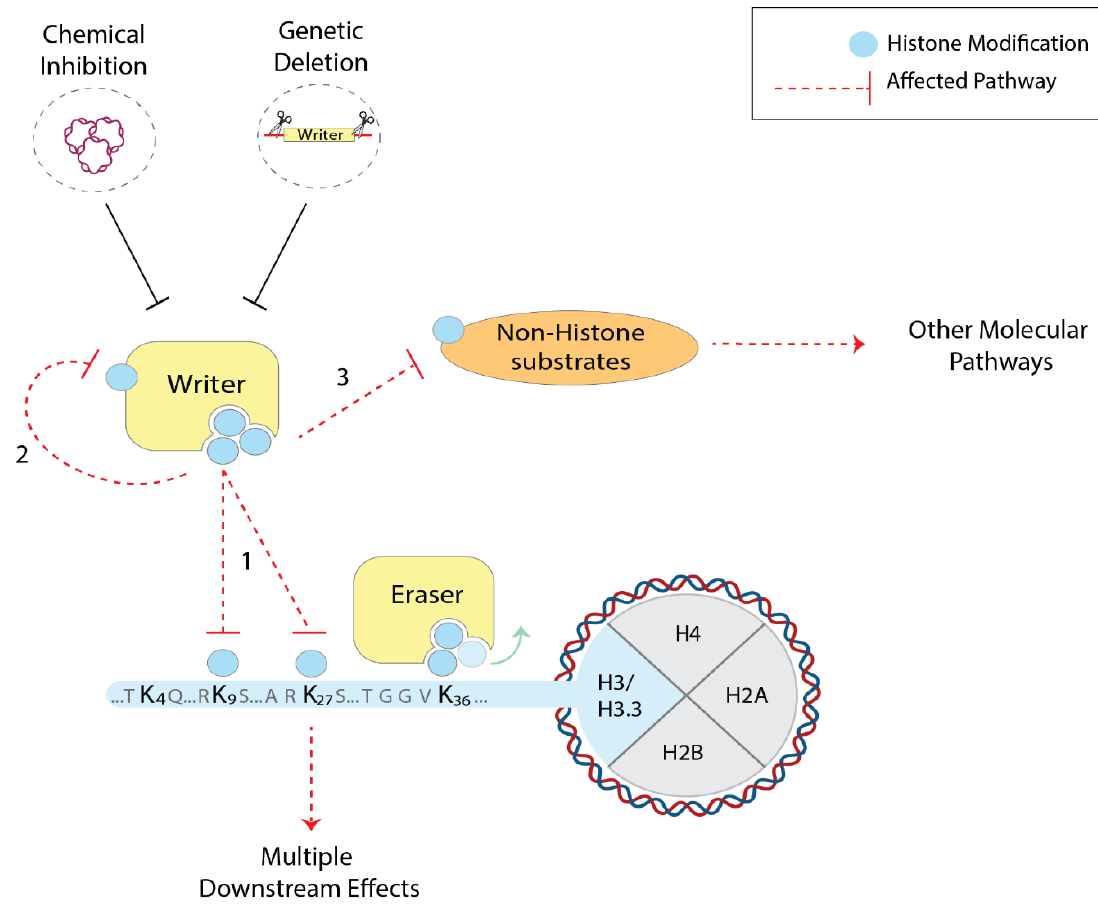
Figure 1. Chemical and genetic perturbation of chromatin factors to investigate histone residues and PTMs in mammals. Histone writers (yellow) can often post-translationally modify multiple histone residues (1), but also themselves (2) and other non-histone substrates (3). As a consequence, when employing the chemical and genetic perturbations of such enzymes, multiple cellular pathways can be affected (red dashed arrows), making it difficult to infer the role of histone PTMs.